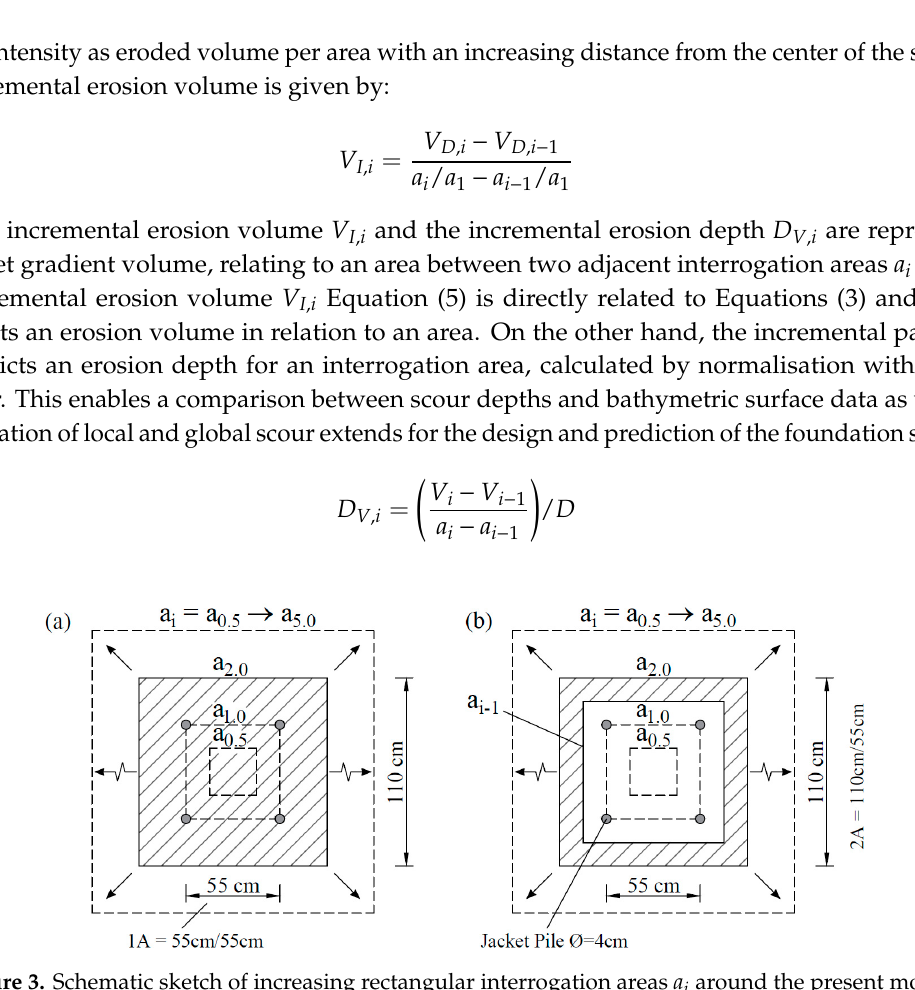
Figure 3. Schematic sketch of increasing rectangular interrogation areas a i around the present model, ( a ) illustrated exemplarily for an area a i = a 2 , related to Equation (4) ( a 2 = 1.1 × 1.1 m, shaded area); ( b ) as well as increasing incremental areas, related to Equation (5). Interrogation areas a i are centered to the structure, starting at a 0.5 up to a 5 .